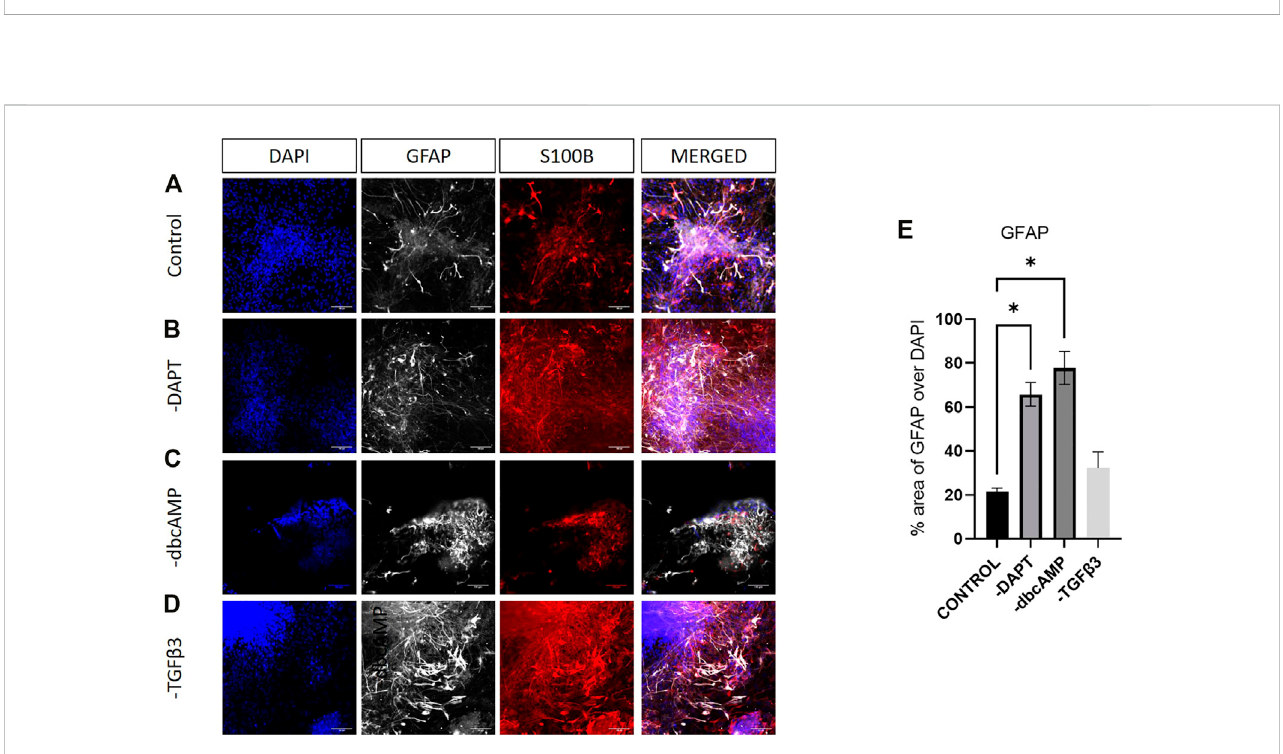
FIGURE 7 Immunolabelling of GFAP and S100B in LMX1A-eGFPcultures. Panel (A) shows, from leftto right, DAPI nuclear labelling (blue), GFAP (white), S100B (red) and a color combined image (merged). Panels (B – D) show the corresponding data, but following cultivation in the absence of DAPT, dbcAMP and TGF β 3, respectively. Scale bar indicates 100 μ m. Panel (E) shows GFAP fl uorescence as a fraction of DAPI fl uorescence ( n = 3).Bar graphs show mean +/- s. e. mean; * = p <